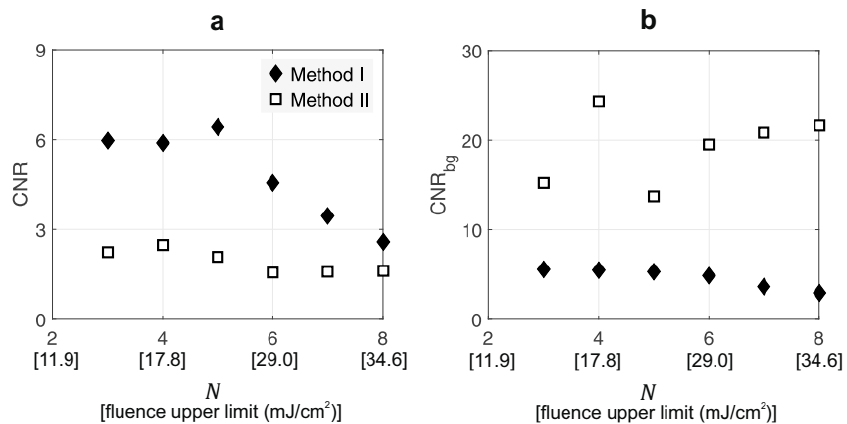
Figure 7. ( a ) Contrast-to-noise ratio (CNR) and ( b ) contrast-to-background-noise ratio (CNR bg ) of Methods I and II as a function of the number of images N included in the analysis. The maximum fluence is shown in brackets. CNR and CNR bg are defined by Equations (3) and (4).